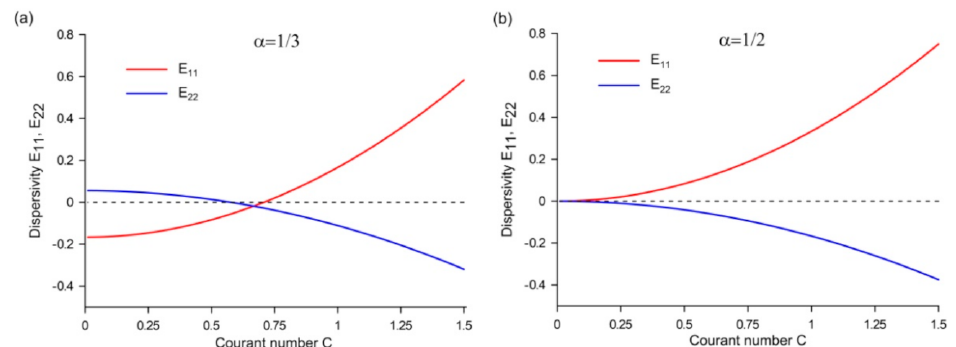
Figure 4. The values of the dispersivity tensor components E 11 and E 22 versus the Courant number C calculated using the 6N mesh structure for: ( a ) α = 1/3; ( b ) α = 1/2.